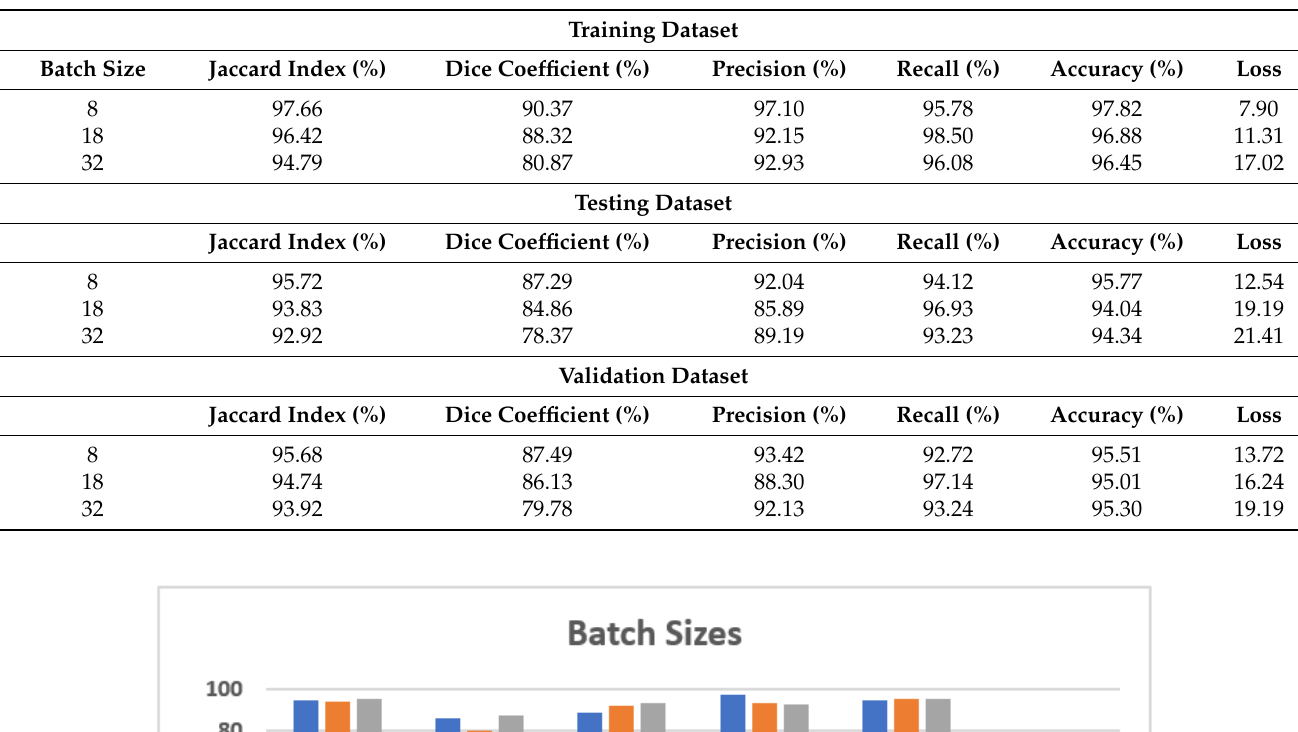
Table 3. Analysis of Different Batch sizes using the Adam Optimizer.